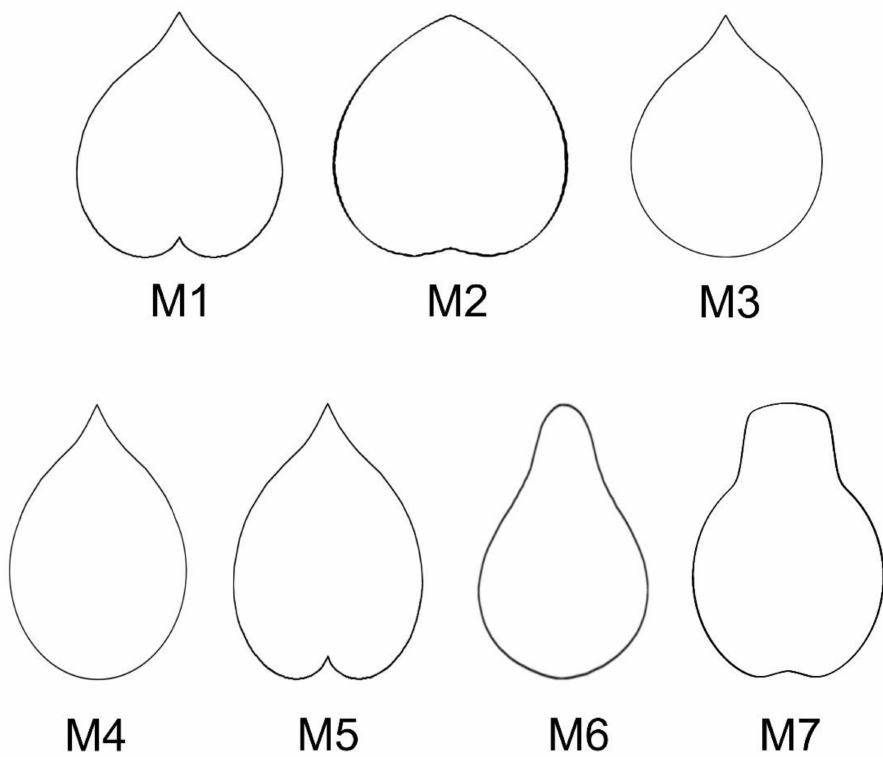
Figure 2. Geometric models for the quantification of shape in seeds of the Vitaceae: (M1) The fourth heart curve of Weisstein [31]. (M2) A rounded heart curve modified from M1. (M3) The water drop, obtained from M1, adapting the basis in the heart curve to a circumference overlapping the maximum width of the curve. (M4) Obtained by scalling M3 in the y-axis by a factor of 123 / 100. (M5) Obtained by scalling M1 in the y-axis by a factor of 123 / 100. (M6) Fibonacci’s pear, obtained by scalling the pear curve of Weisstein [30] with r = 2 in the y-axis by a factor equal to the Golden Ratio Φ . (M7) Derived from an